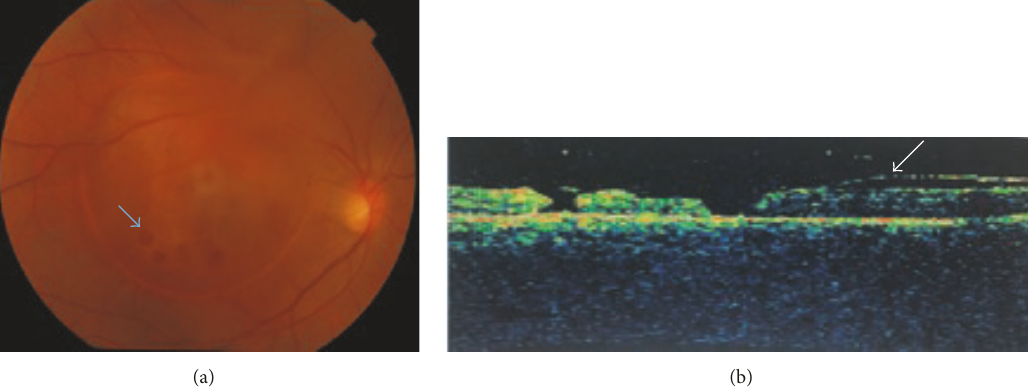
Figure 1: (a) Blue arrow indicates retinal hole. (b) White arrow indicates detached thickened